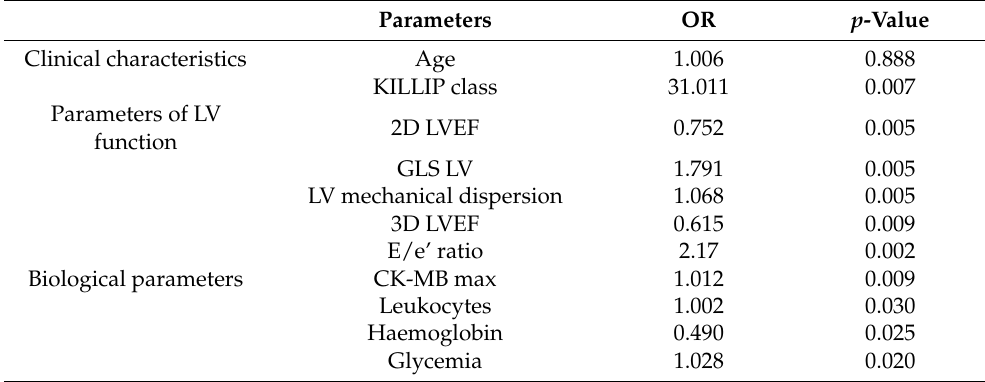
Table 3. Univariate binary logistic regression to assess the ability of various parameters to predict LVR. Parameters OR p -Value Clinical